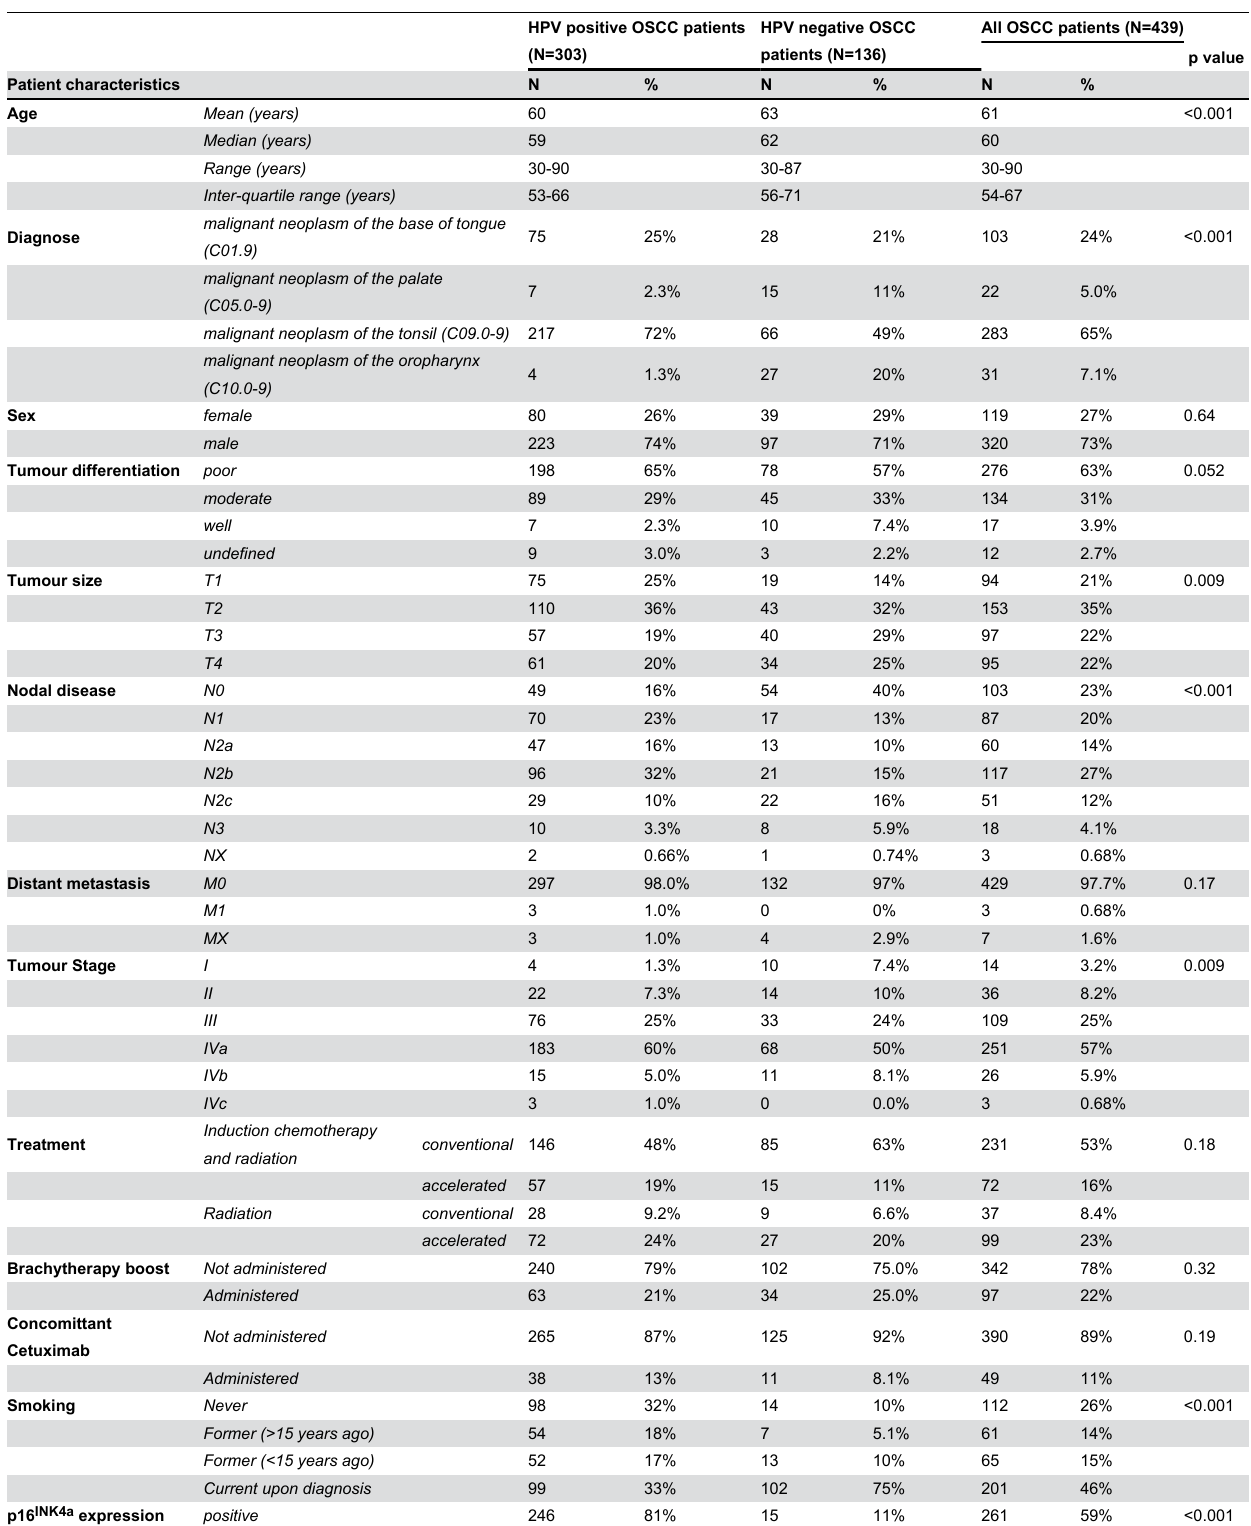
Table 1. Characteristics of patients* included in the study and their